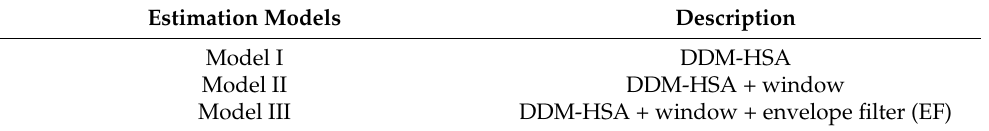
Table 2. Description of the